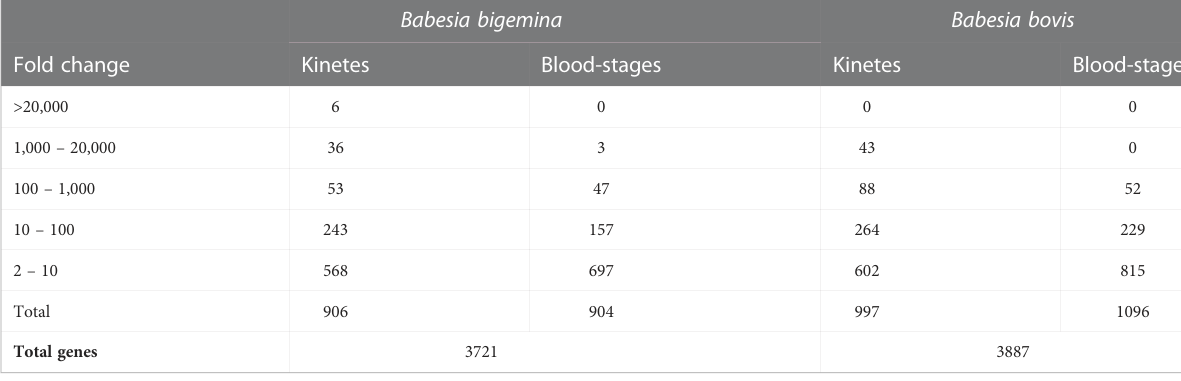
TABLE 1 Comparative transcription levels between B. bigemina and B. bovis kinetes and blood-stages.